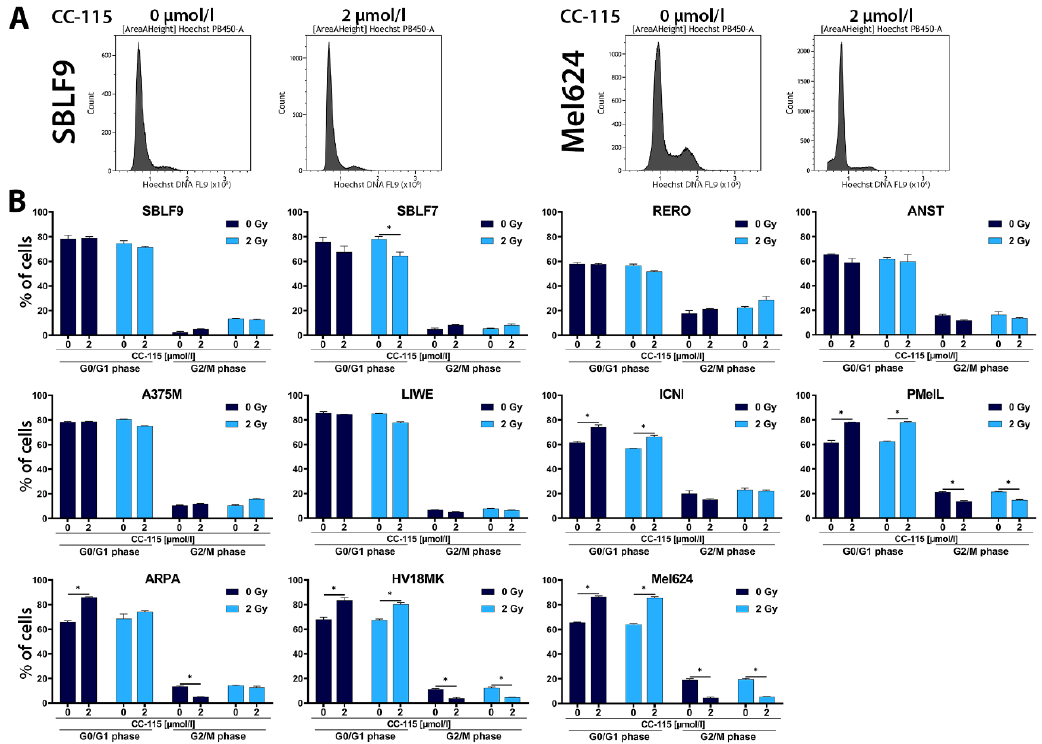
Figure 3. Cell cycle distribution under CC-115 treatment with / without IR. ( A ) Flow cytometry was used for cell cycle analysis by Hoechst staining. Examples of representative histograms of Hoechst stained DNA distribution for control and 2 µ mol / L CC-115 are shown, left: healthy-donor skin fibroblasts (SBLF9), right: melanoma cells (Mel624). ( B ) Graphs show the percentage of cells in G0 / G1 phase (left columns) or G2 / M phase (right columns) for 0 and 2 µ mol / L CC-115 with / without IR (2 Gy) in skin fibroblasts (SBLF9, SBLF7) and melanoma cells (RERO, ANST, A375M, LIWE, ICNI, PMelL, ARPA, HV18MK, Mel624). Each value represents mean ± SD ( n = 3). Significance was determined by one-tailed Mann-Whitney U test * p ≤ 0.05.